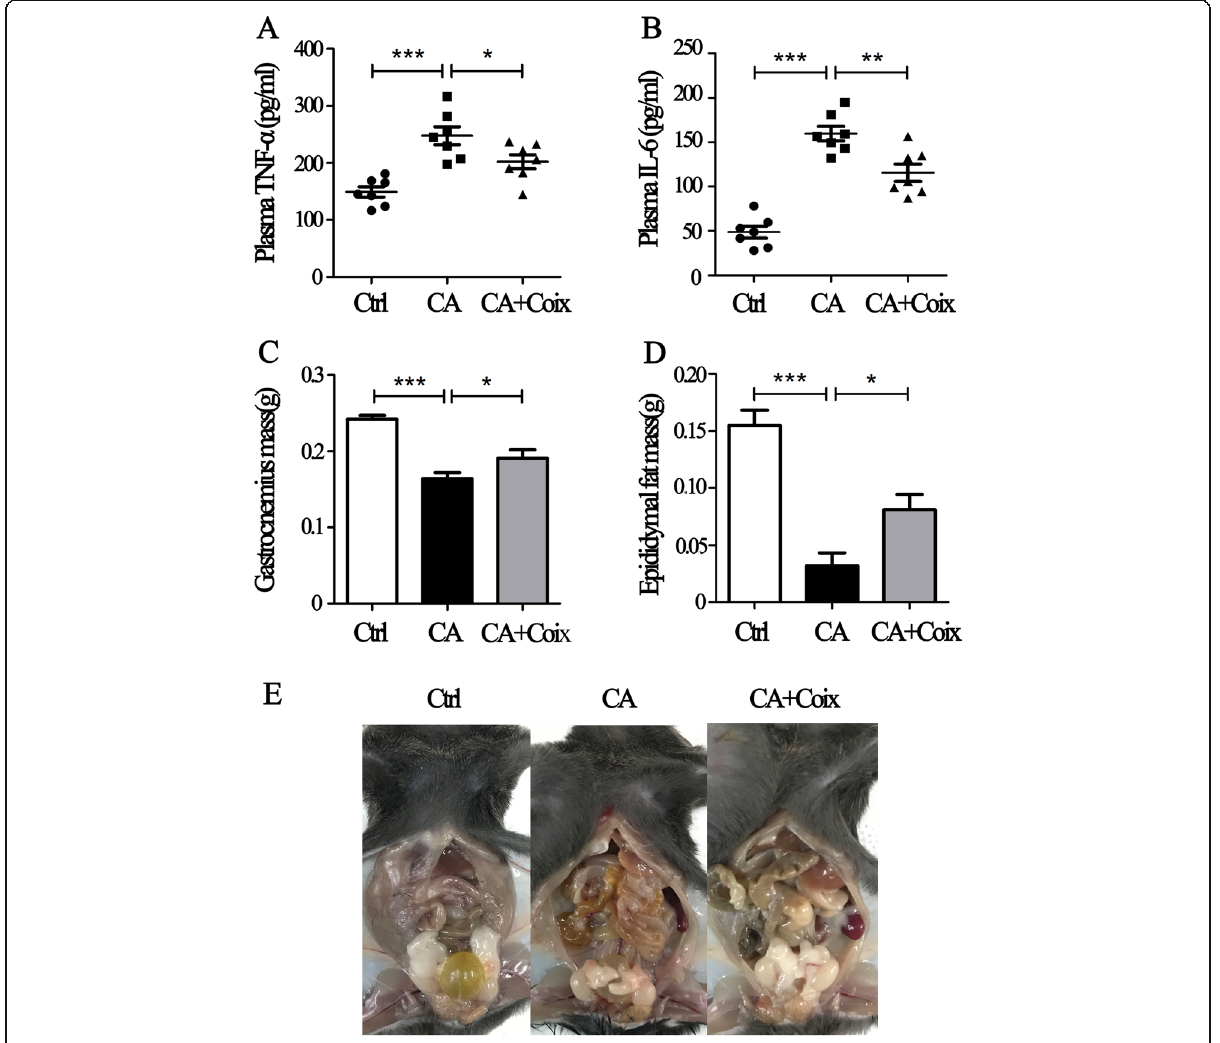
Fig. 2 CSO alleviated systemic inflammation, counteracted muscle and fat loss. A, B. CSO administration significantly reduced the levels of TNF- α ( a ) and IL-6 ( b ) in the serum of cachectic mice. c . Tumor-bearing mice suffered from significant muscle loss while CSO significantly ameliorated the muscle wasting. d . CSO administration remarkably elevated epididymal fat weight in cachectic mice. e . Representative figures of epididymal fat inthree groups (Ctrl, CA, CA + Coix). Values were expressed as mean ± SEM (* P <0.05, ** P <0.01, *** P